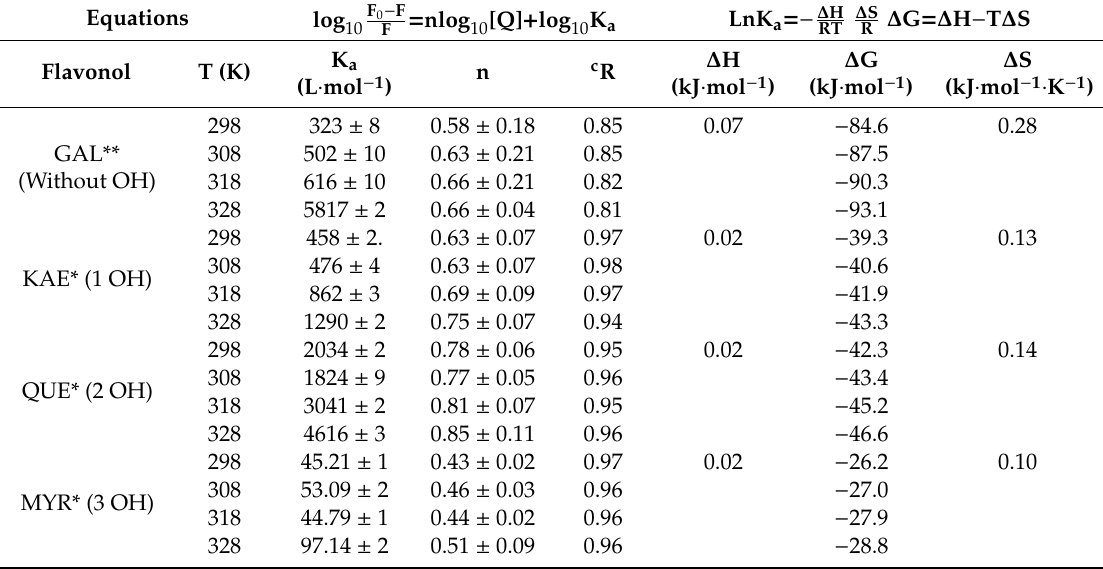
Table 2. Biophysical parameters of molecular complexes formed between CpLIP2 lipase and flavonols (GAL, galangin; KAE, kaempferol; QUE, quercetin; MYR, myricetin) determined from Stern–Volmer equations at di ff erent temperatures (298, 308, 318, 328 K). Number of binding sites (n), association constant (K a ), enthalpy changes ( ∆ H), entropy changes ( ∆ S), and free energy change ( ∆